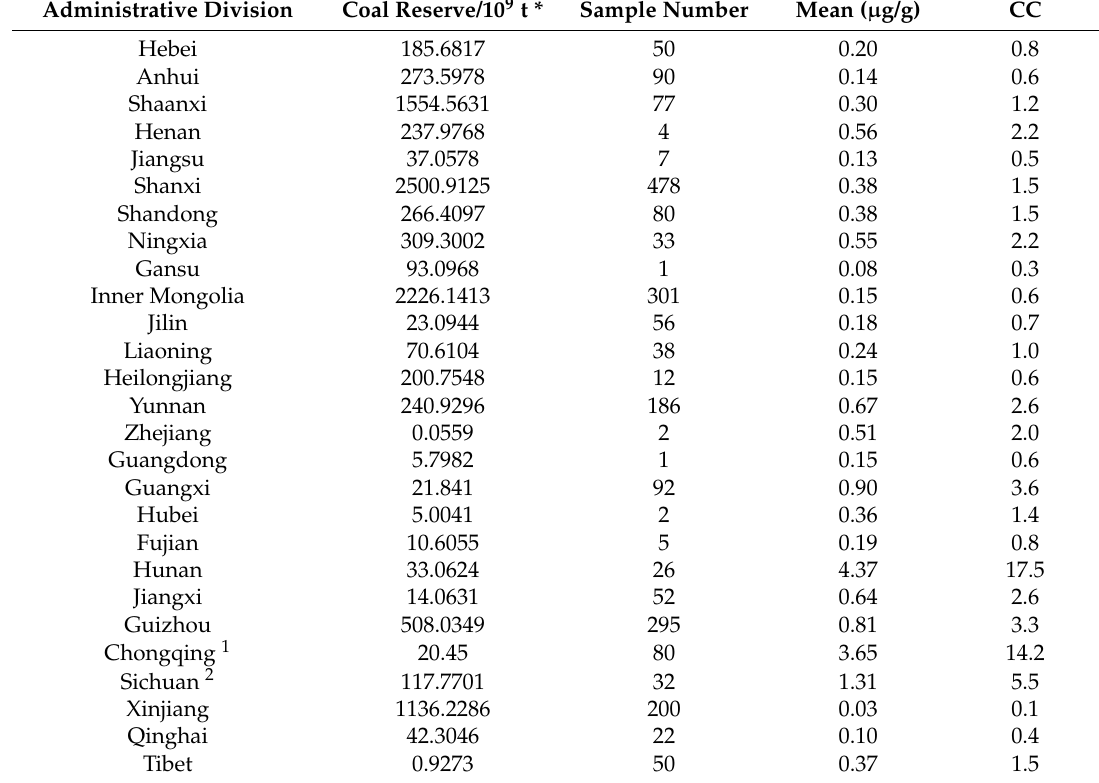
Table 5. Cadmium abundance in different provinces in China.